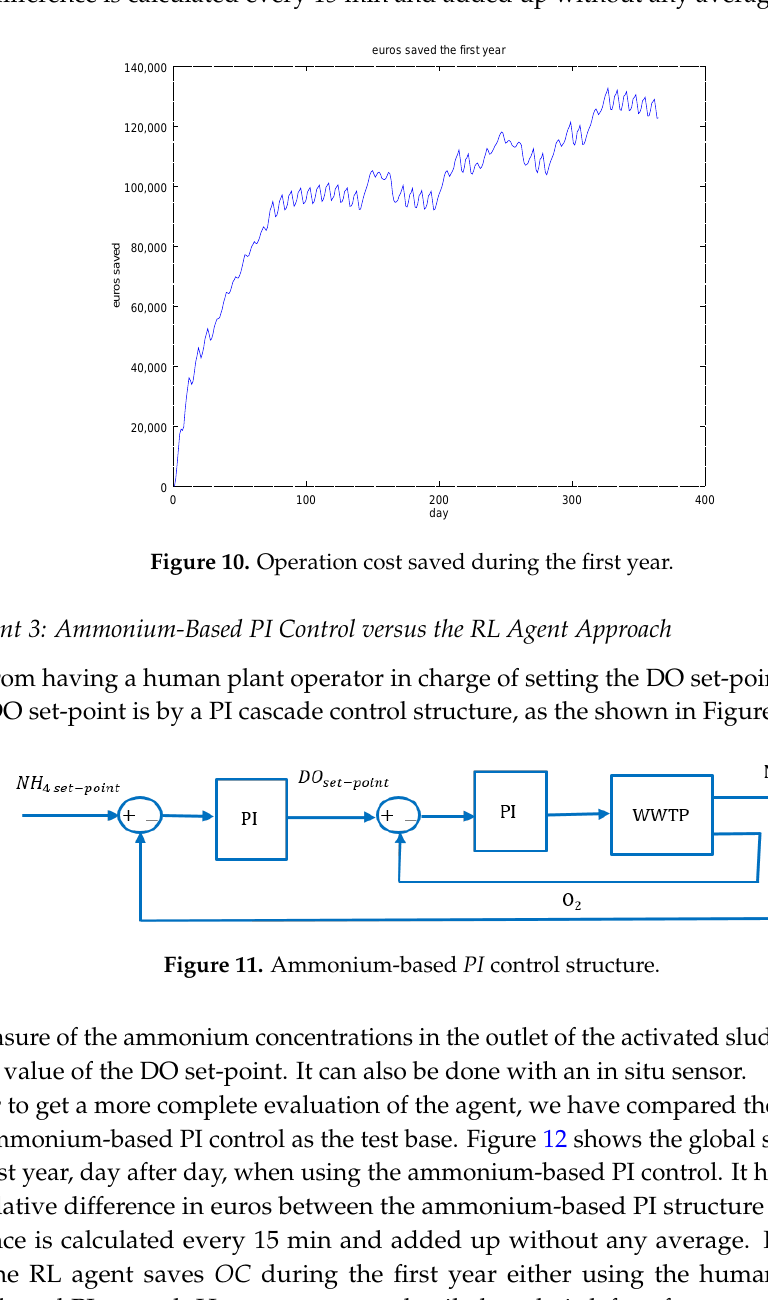
Figure 9. ( a ) Monthly cost after the first week of learning; ( b ) monthly cost after the first month of learning; ( c ) yearly cost after one year of learning.